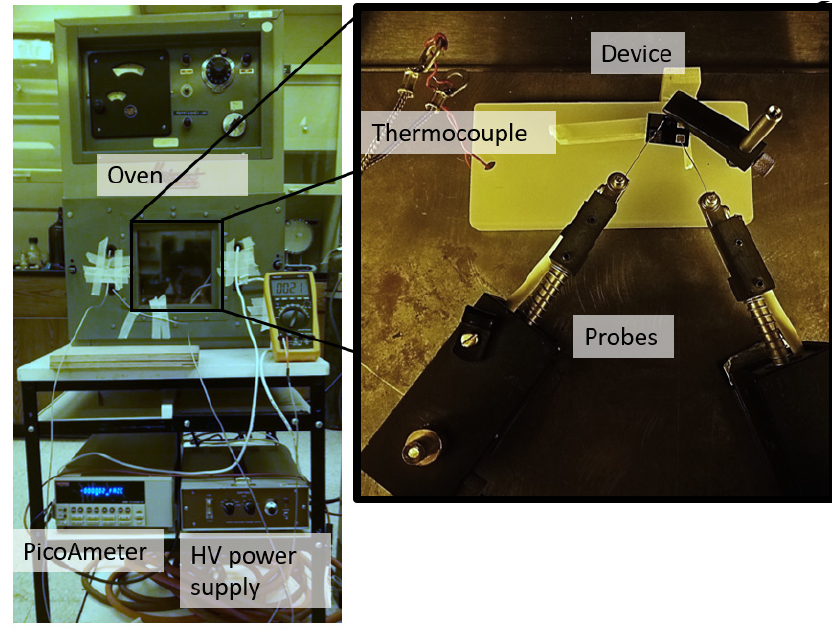
Figure 2. The poling setup, with a view of the probe configuration inside the